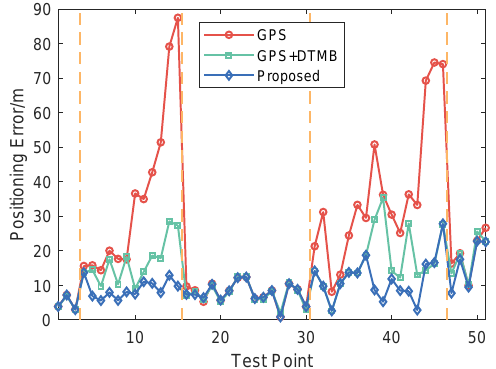
Figure 10. Positioning error at each test point at Site 1.